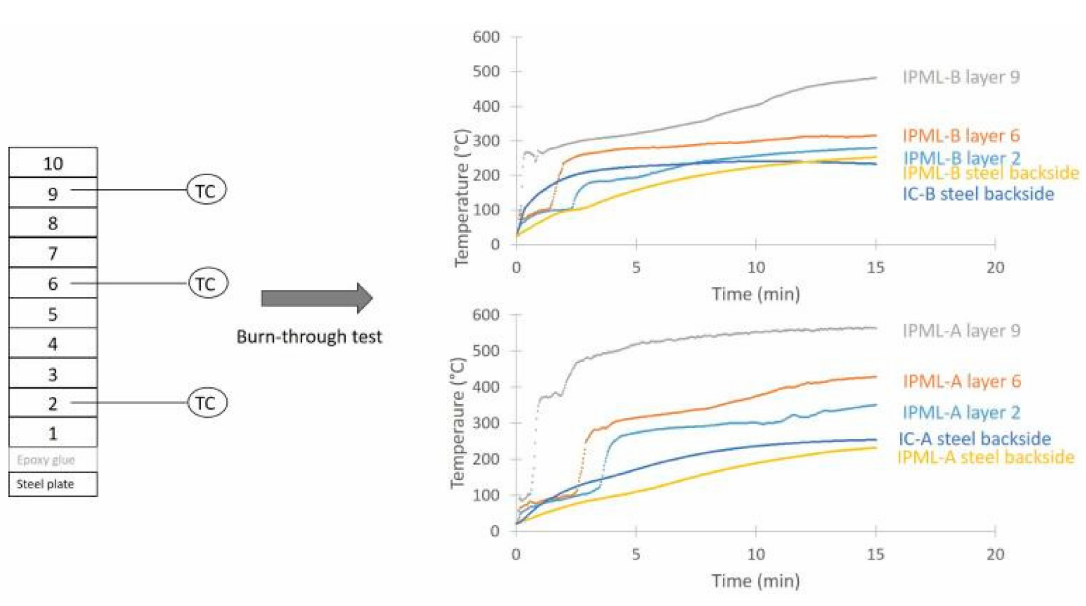
Figure 10. Thermal gradient evolution in IPML-A and IPML-B.